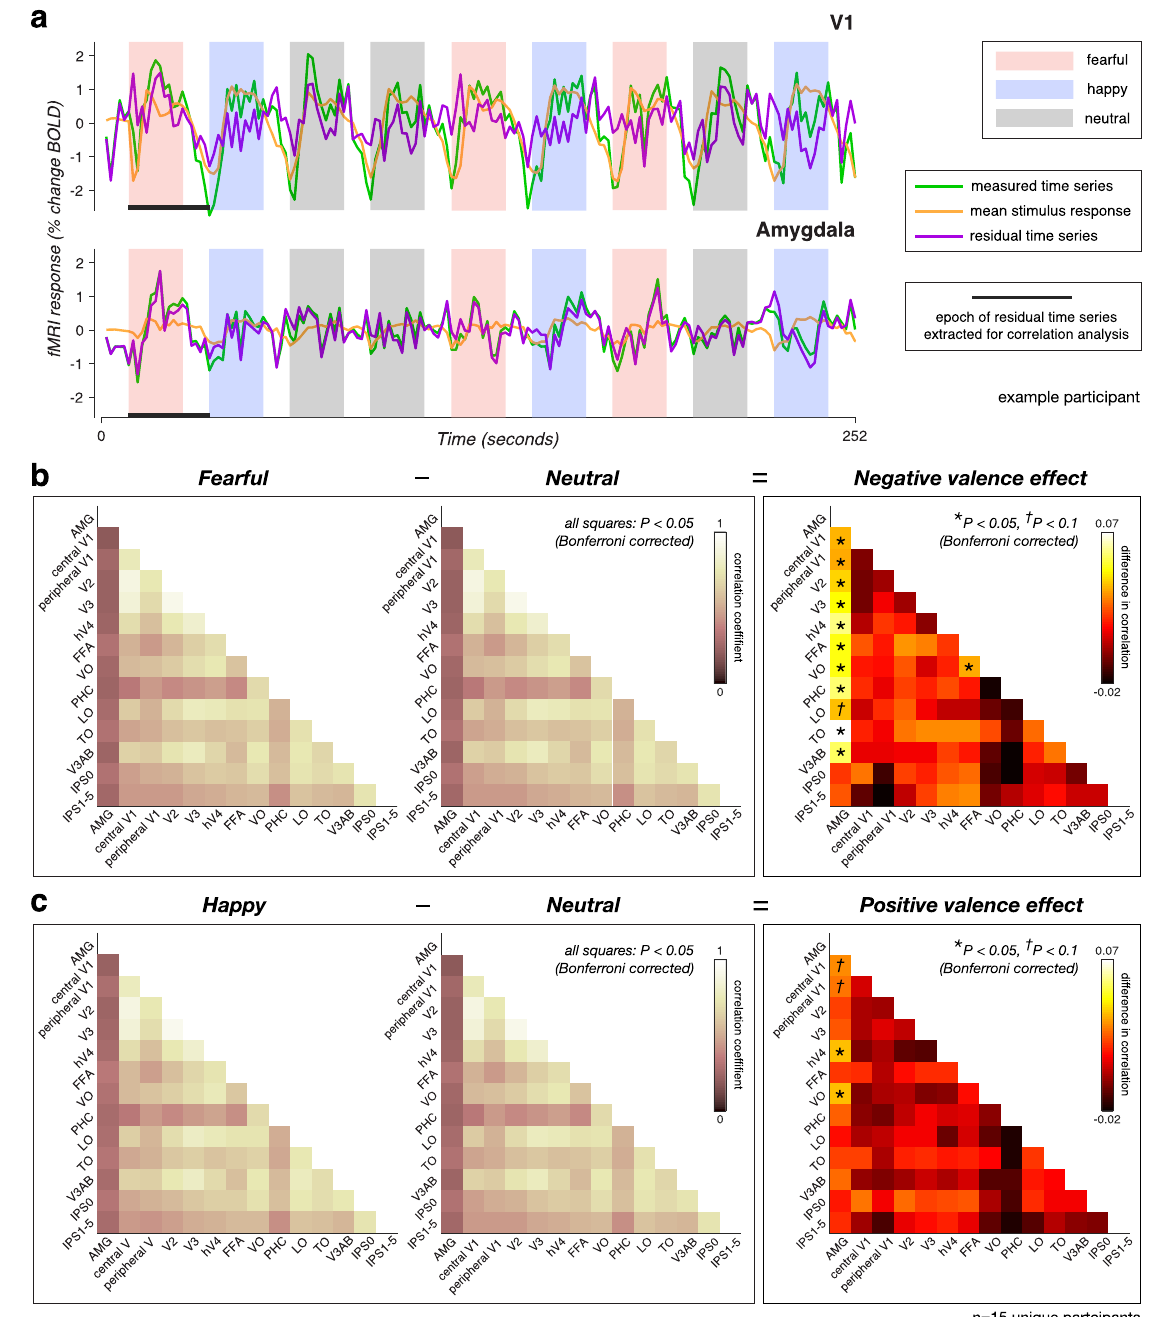
Fig. 2 | Inter-area correlation reveals enhanced interactions with amygdala when viewing fearful facialexpressions.a fMRI timeseries from V1(top)and the amygdala (bottom) from a single run from an example participant in the 7T BOLD experiment, consisting of three 18s blocks of trials of each facial expression (pink: fearful; blue: happy; gray: neutral) with interleaved blocks of fi xation of 9s. Three timeseriesareplotted:green,measuredtimeseries;orange,meanstimulus-evoked response (estimated using deconvolution); purple, residual time series after removing the mean stimulus-evoked response. Horizontal black bars indicate the epoch of residual time series that was extracted for correlation analysis. b Correlationcoef fi cientsforfearfulfacialexpressioncondition(left),neutralfacial expressioncondition(middle),and thedifferencein correlation(fearful − neutral), indicating the negative valence effect (right). Each square in “ pink ” colormap indicates the correlation between residual time series for a pair of ROIs under fearful facial expression condition (left) or neutral facial expression condition (middle). Each square in “ hot ” colormap indicates the difference in correlation